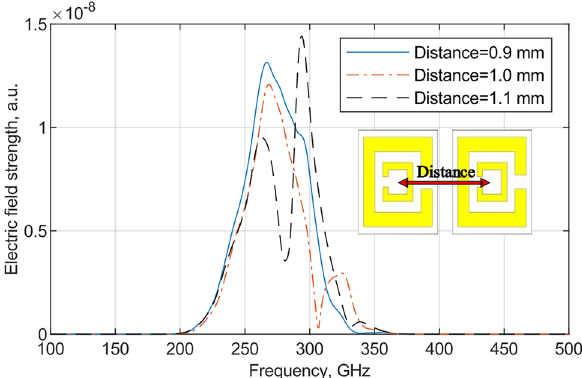
Figure 5. Simulated electrical field strength at front of the FSS illuminated by TE mode planewave from the rear side, with three different interelement spacings. Change in inter element spacings leads to a change in the bandwidth.